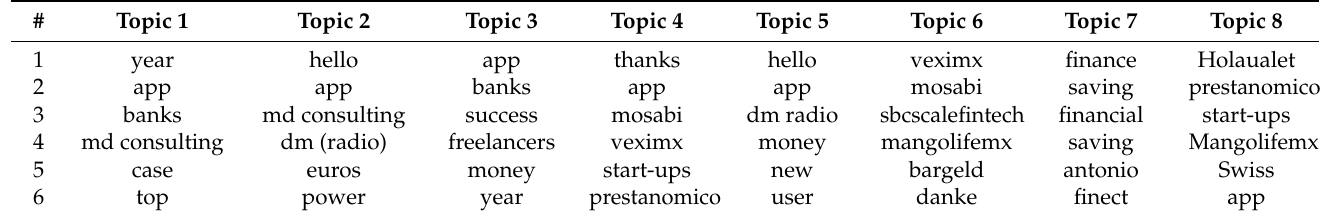
Table 6. Topic modeling results of the personal finance